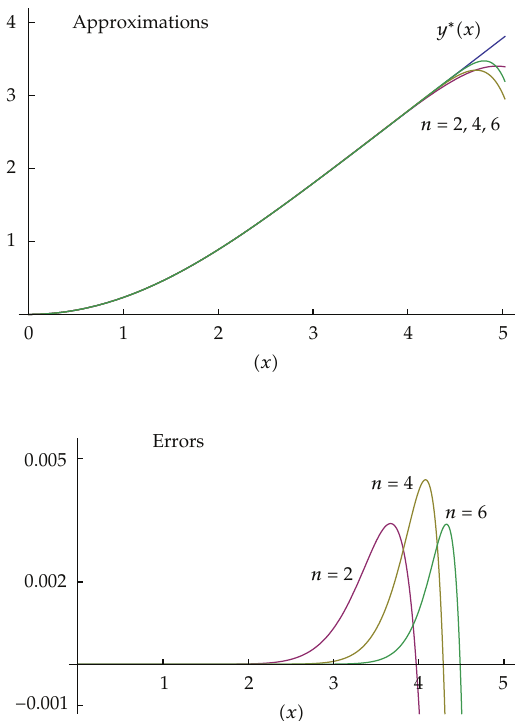
Figure 6: Corrected solutions (cid:24) y n (cid:3) x (cid:4) of the presented solutions y n (cid:3) x (cid:4) and their errors, n (cid:6) 2 , 4 , 6 (cid:3) β (cid:6) 0 (cid:4) . Table 2: Comparison of the L 2 -norm errors of the Adomian solution y A n (cid:5) and its correction (cid:24) y n (cid:3) x (cid:4) for various values of β